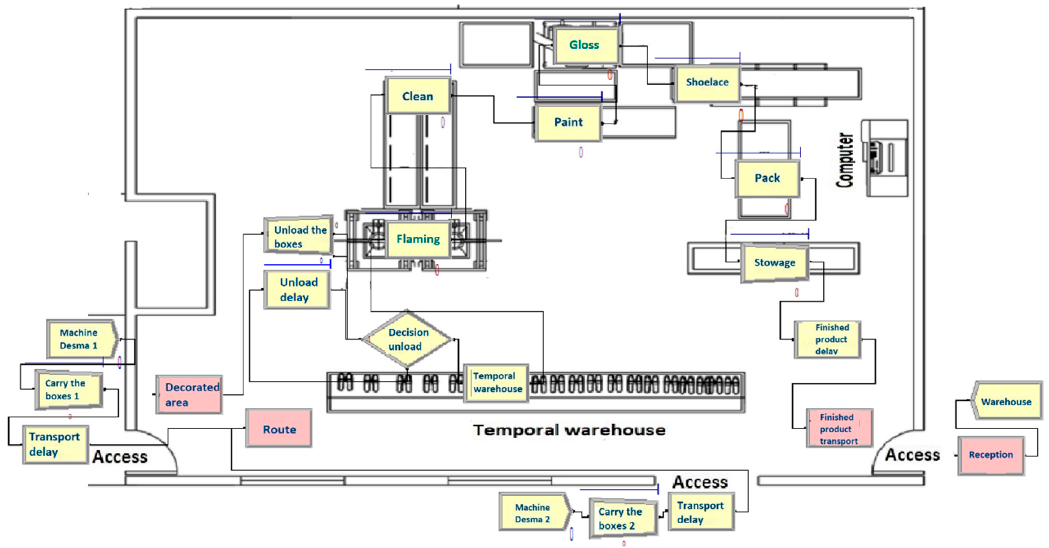
Figure 10. Arena ™ model of the proposal elaborated by the author.